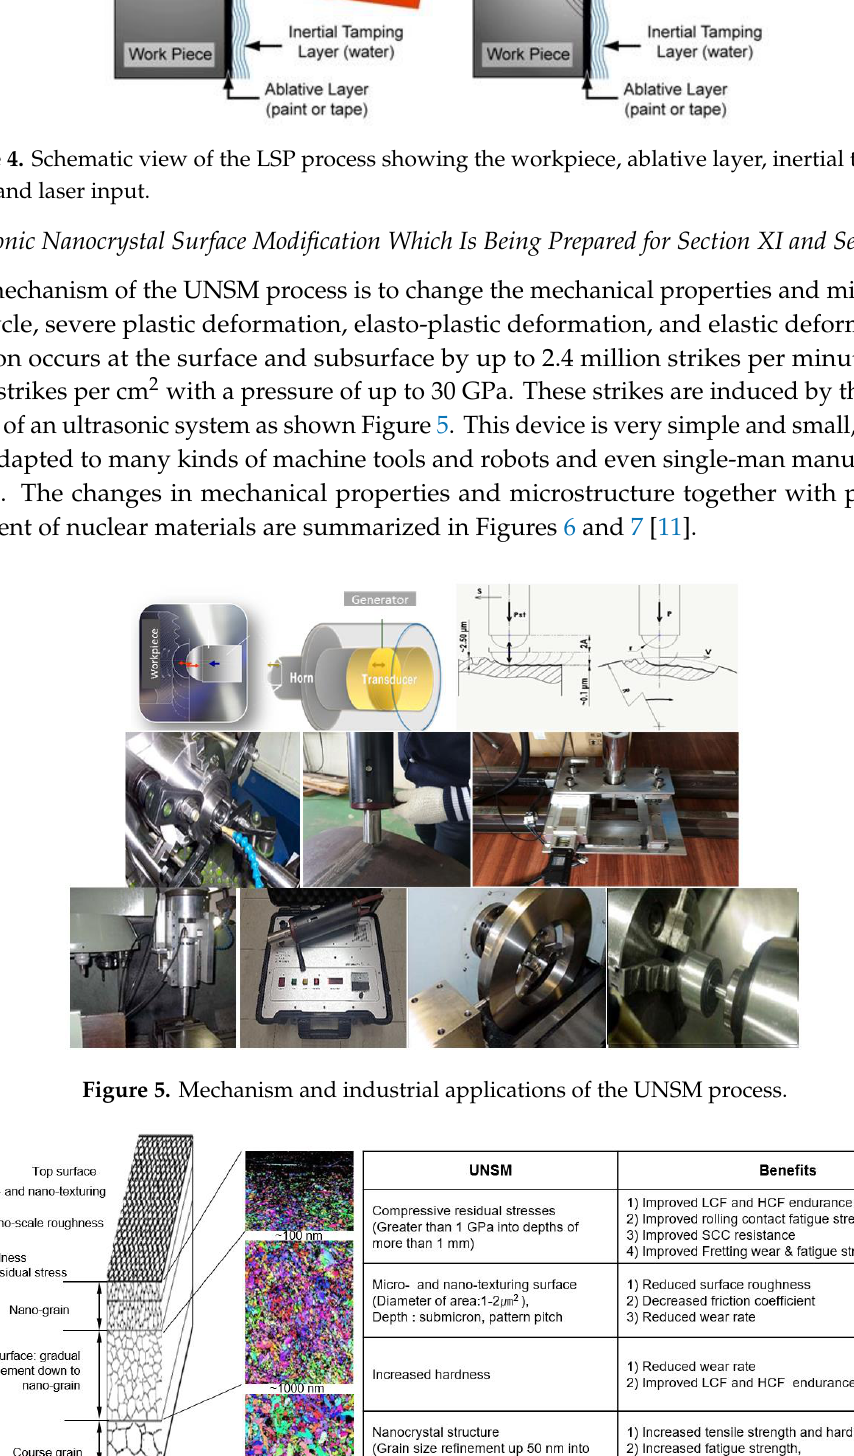
Figure 4. Schematic view of the LSP process showing the workpiece, ablative layer, inertial tamping layer, and laser input.